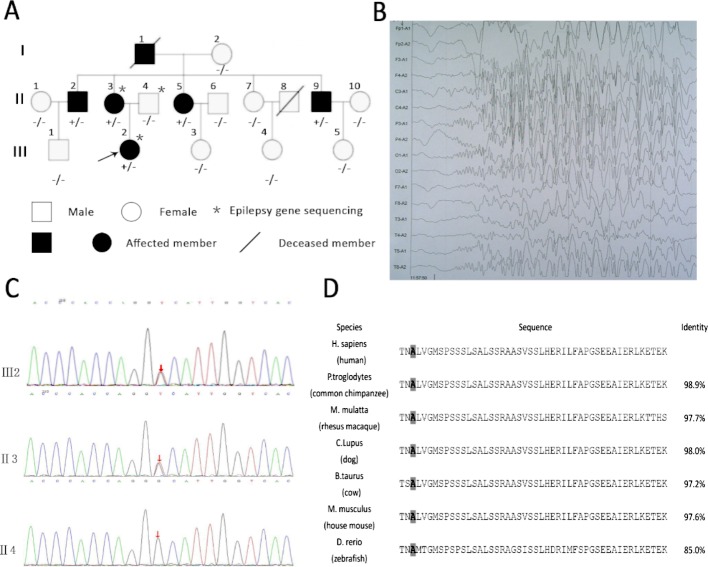
Rare variants in KIF1A detected in a family and KIF1A are conserved across species. (A) Rare mutation in KIF1A detected in a family. (B) Electroencephalogram (EEG) of the proband (III2) showing generalized sharp waves. (C) The analysis of sequences of affected girl (III2), affected mother (II3), and unaffected father (II4). (D) The amino acids coded by variation are conserved across species as showing in the boxed. The last column shows identity with the human protein. The gray boxes highlight the amino acids mentioned in the manuscript.